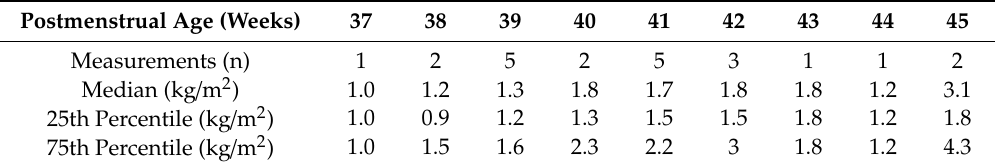
Table 9. Evolution of adiposity indicated by fat mass index (FMI) (kg / m 2 ) after term postmenstrual age, in a subset of infants (n = 15) born preterm and at